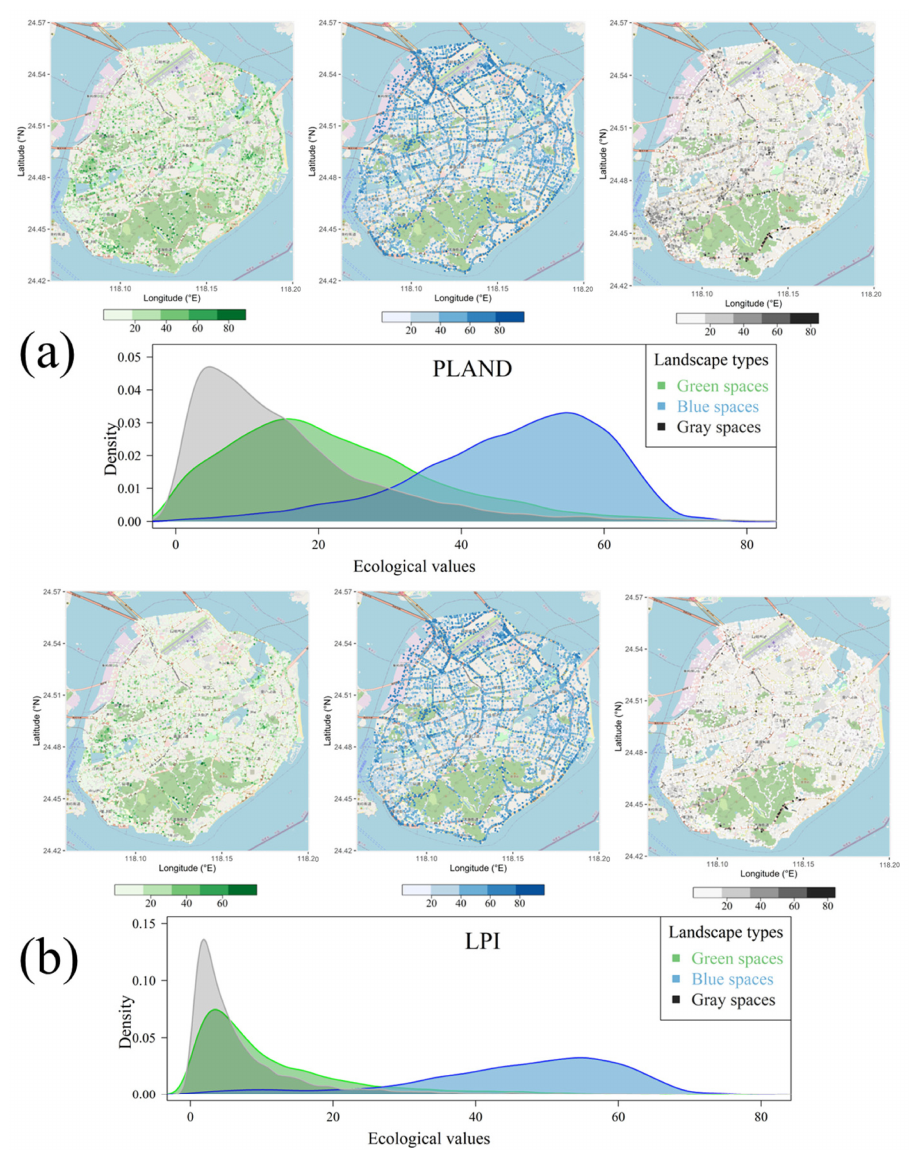
Figure 5. The spatial and density distribution for ecological landscape indicators, ( a ) for PLAND and ( b ) for LPI.